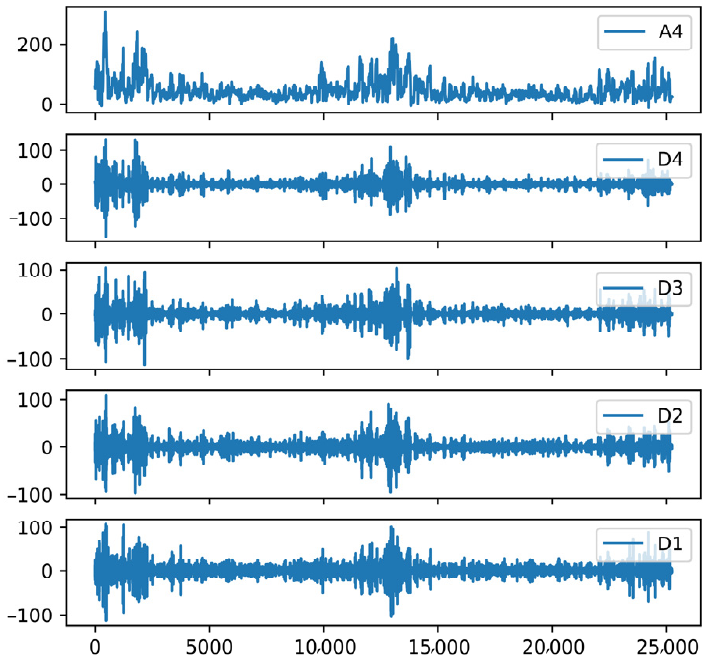
Figure 3. Graph of wavelet decomposition results.